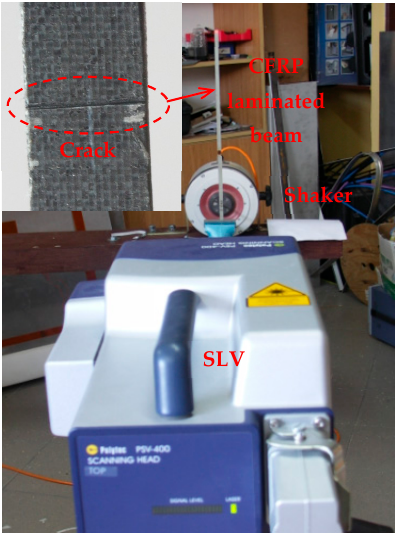
Figure 13. Experimental setup.